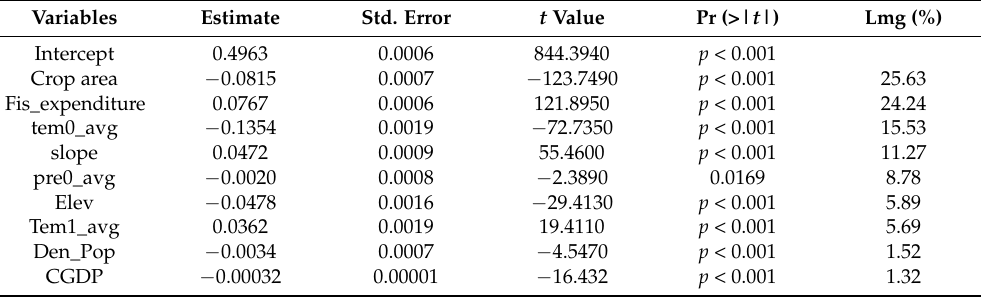
Table 4. Results of the Multiple Linear Regression model with 9 selected variables.